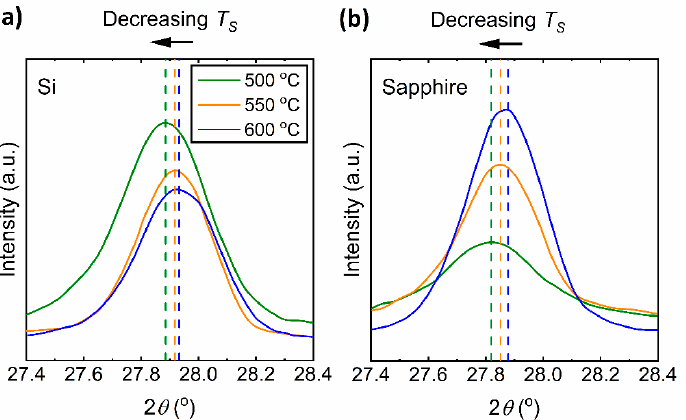
Figure 13. X-ray diffraction of (011) planes of VO 2 thin films deposited at T S = 500, 550, and 600 °C on ( a ) Si and ( b ) sapphire substrates.